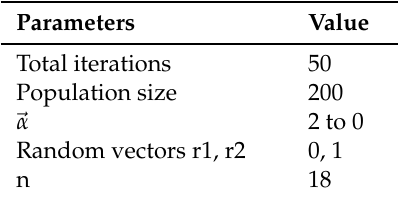
Table 4. Parameters of